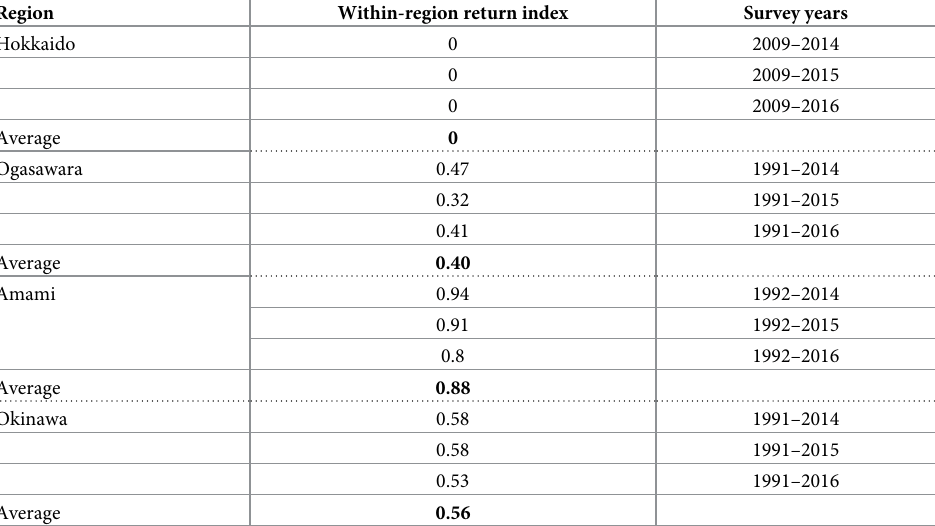
A total of 114 cases with 100 unique individuals (i.e., 35 males, 16 females, and 49 of unknown sex) were observed in two different regions within the same season among Ogasawara, Amami and Okinawa (Table 5). Only one individual (a female) was observed at both Ogasawara and Amami within the same season (Tables 5 and 6). Thirteen cases with 11 unique individuals (i.e., six males, three Table 4. Within-region return indices and the survey years for each of the sighting regions. Region Within-region return index Survey years